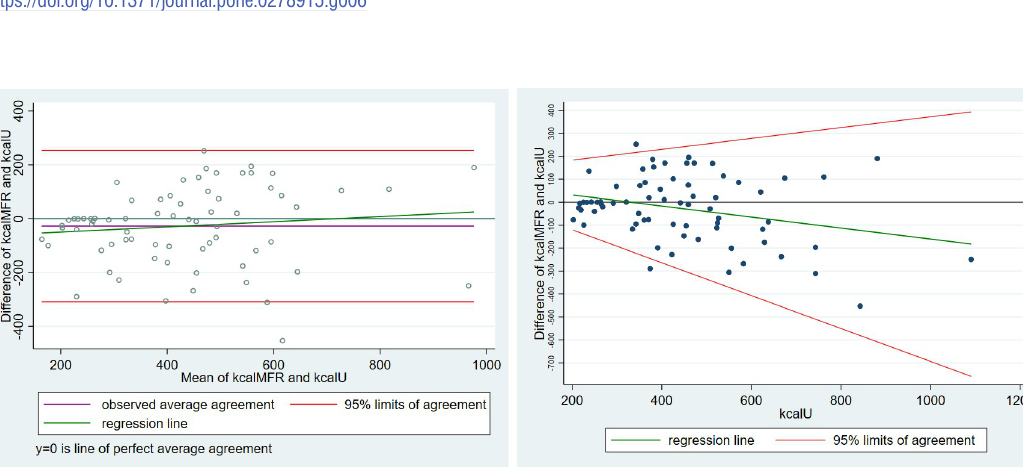
Fig 6. (Left) Classical Bland-Altman LoA plot augmented with the regression line, for low-caloric aliment cluster (right) Linear regression of the differences (y1—y2) on y2 with 95% limits of agreement.